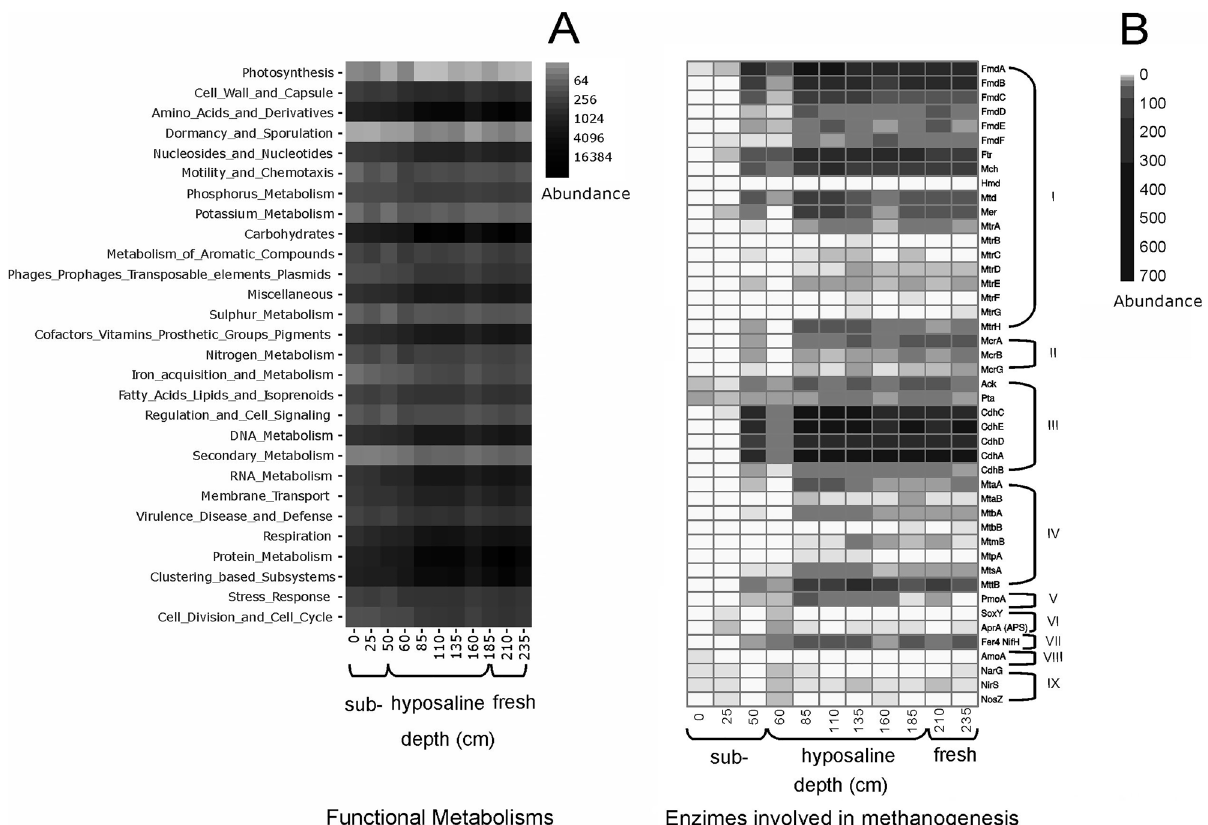
Figure 4. ( A ) Functional classification of the predicted proteins of the Lake Chalco sediment metagenomes, using SEED Subsystems. Samples are ordered from shallowest to deepest samples. Log2 normalization of abundance is shown. ( B ) Enzymes associated with different, presumably active metabolic pathways. Heatmap distribution of the enzymes (or subunits of the enzymes) of: (I) hydrogenotrophic methanogenesis (FmdA-MtrH), (II) shared key enzymes for all variants of methanogenesis (McrA-McrG), (III) acetoclastic methanogenesis (Ack-CdhB), (IV) methylotrophic methanogenesis (MtaA-MttB), (V) aerobic methane oxidation (PmoA), (VI) sulphur metabolism (SoxY-AprA), (VII) nitrogen fixation (NifH), (VIII) nitrification (AmoA) and (IX) denitrification NarG-NosZ), in the different sampled units. The numbers on the sidebar represent the abundance. Edited in CorelDRAW 2020 version